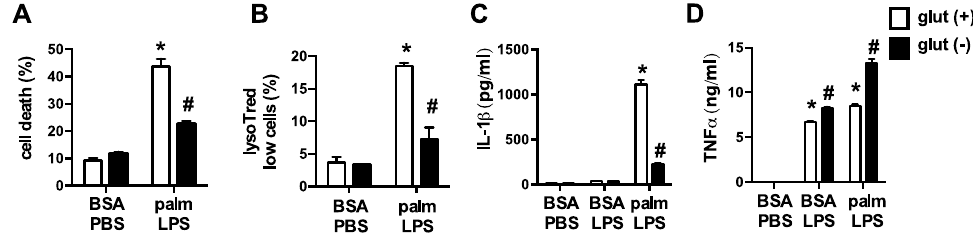
Figure 2. Glutamine deficiency protects against lipotoxicity in macrophages. ( A , B ) pMACs were stimulated with BSA-PBS or palm-LPS in glutamine sufficient (open bars) or glutamine deficient (black bars) media and cell death was assessed at 30 h by annexin-PI ( A ), or lysosome damage was determined at 24 h by lysotracker red staining ( B ), both coupled with flow cytometry; ( C , D ) After the indicated stimulations IL-1 β ( C ) or TNF α ( D ) release was quantified in the supernatant using ELISA. Bar graphs report the mean ± SE for a minimum of 3 experiments, each performed in triplicate. * , p < 0.05 for PBS vs. LPS; #, p < 0.05 glutamine vs . no glutamine. 3.2. Oxidative Glutamine Metabolism Is Partially Responsible for the Protection from Lipid Toxicity Upon entering the cell, glutamine can be broken down by glutaminase to glutamate, which is then converted to α‐ ketoglutarate ( α‐ KG) for oxidation in the TCA cycle. To determine whether